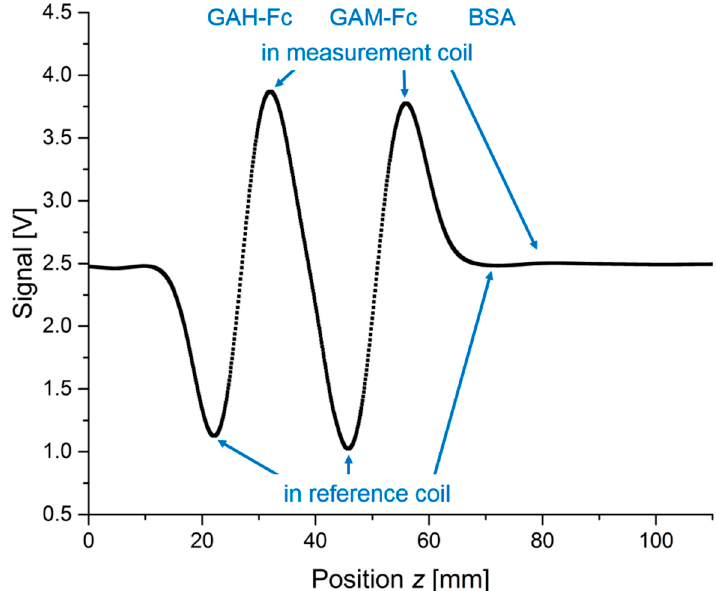
Figure 8. Measurement signal while column 3 is moved through the measurement head. The mean value for each point is shown, the standard deviation is smaller than the size of the data points. Every 0.1 mm, a measurement was performed. The offset of the reader was set so that the signal of the sample can be recorded no matter if the sample is inside the measurement or the reference coil. When the signal is lower than the offset, it means that the sample is inside the reference coil, while higher signals mean that more signal-delivering material is inside the measurement than in the reference coil.